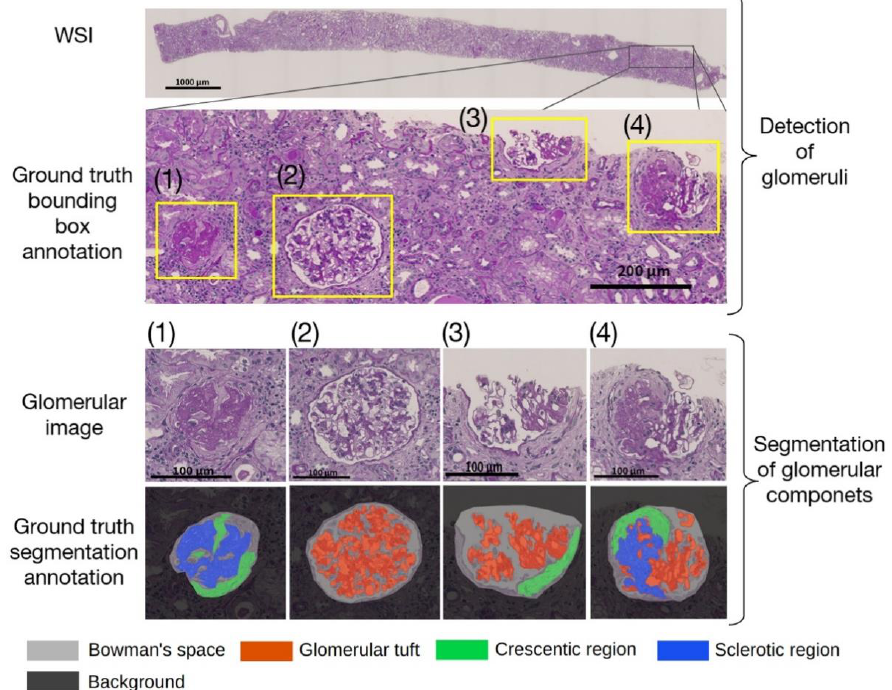
Figure 1. Example of a whole slide image (WSI) ( top row ). The bounding boxes of a glomerulus are shown as a rectangle with a yellow border in the second row. The glomerular images cropped by the bounding boxes are shown in the third row. The annotated images for the segmentation corresponding to the cropped glomeruli are shown in the bottom row. The examples in the ( bottom row ) (1)–(4) include cases with different percentages of sclerotic regions. (1) is an example of global sclerosis, in which there is no glomerular tuft (red). (2) and (3) are examples without sclerosis, in which there is no sclerotic region (blue). (4) is an example of segmental sclerosis, in which the glomerular tuft (red) and sclerotic region (blue) are almost equal in